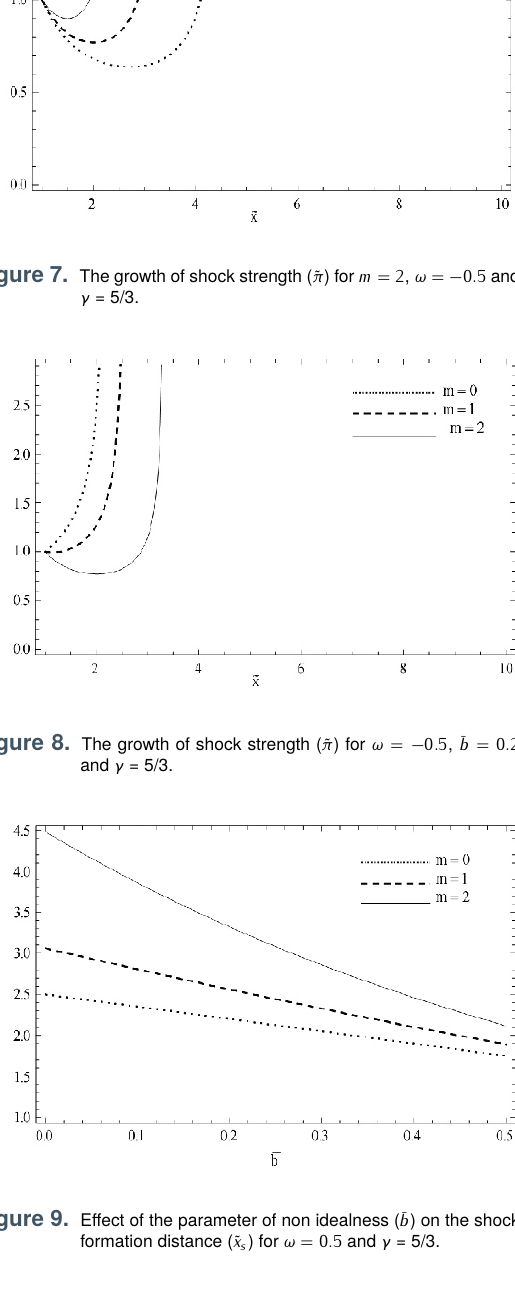
Figure 9. Effect of the parameter of non idealness ( ¯ b ) on the shock formation distance ( ˜ x s ) for ω = 0 . 5 and γ =